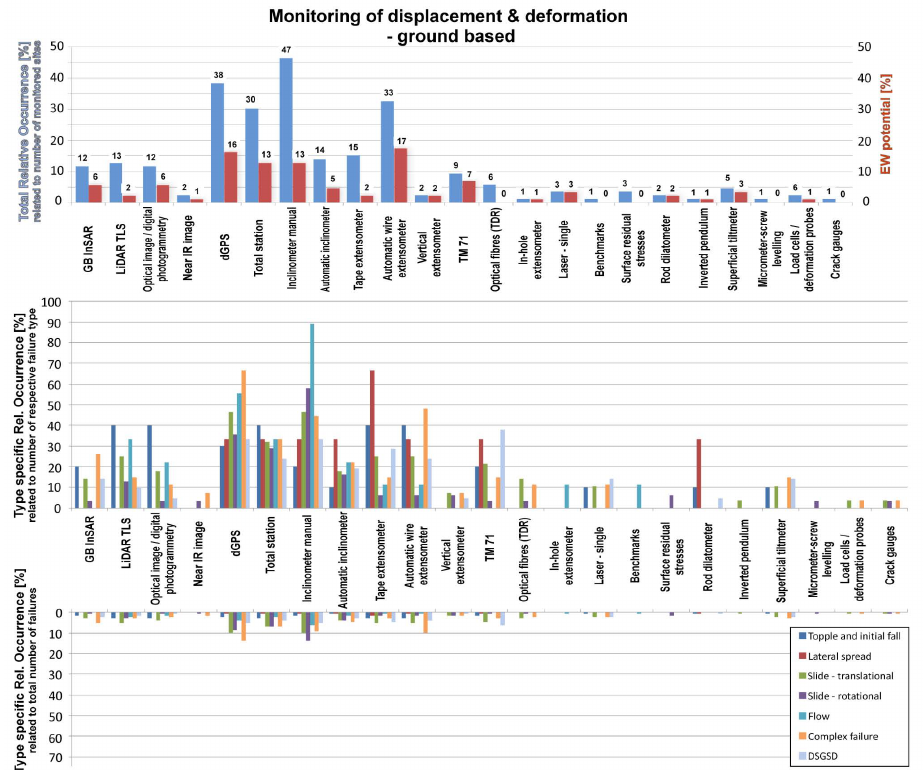
Fig. 9. Review of total relative occurrence, EW potential and type-specific relative occurrence of sensors for displacement and deformation monitoring from the 86 monitored landslide